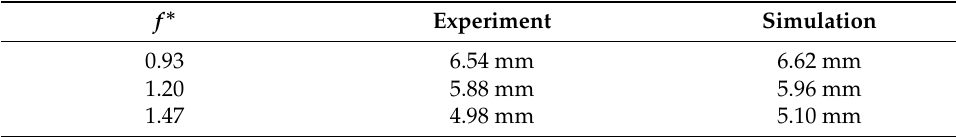
Table 1. Results of trailing edge amplitude A t .